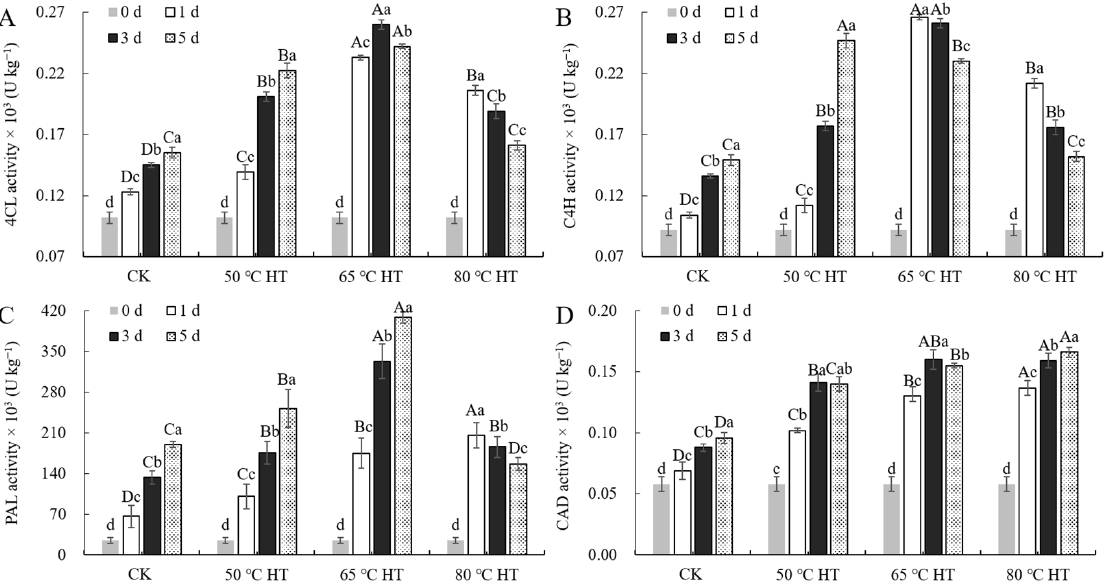
Figure 4. Effects of RHT treatment on PAL, C4H, 4CL, and CAD activity in sweet potato callus (( A ): 4CL activity; ( B ): C4H activity; ( C ): PAL activity; ( D ): CAD activity . Note: Capital letters are comparisons at the same time at different temperatures, and lowercase letters are comparisons at different times at the same temperature).